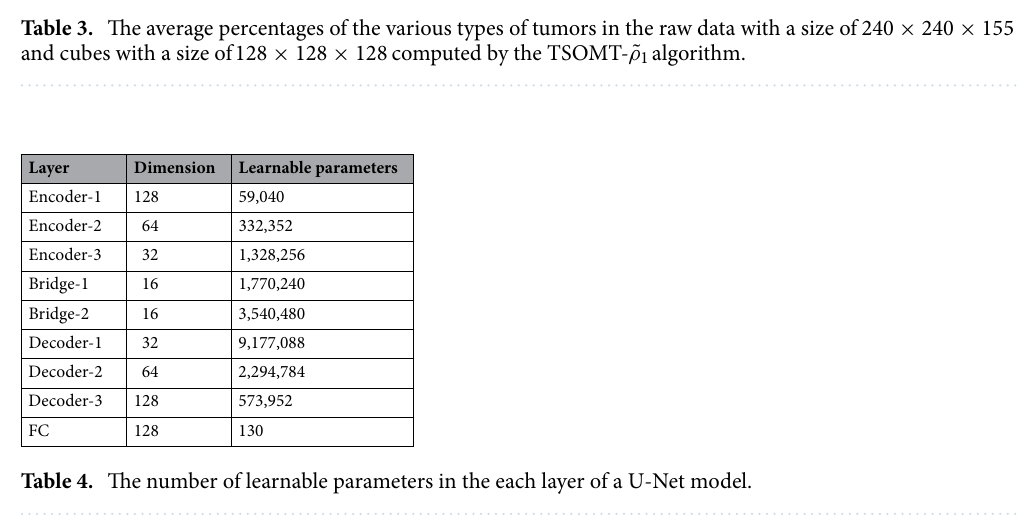
128 128 computed by the TSOMT- × ×